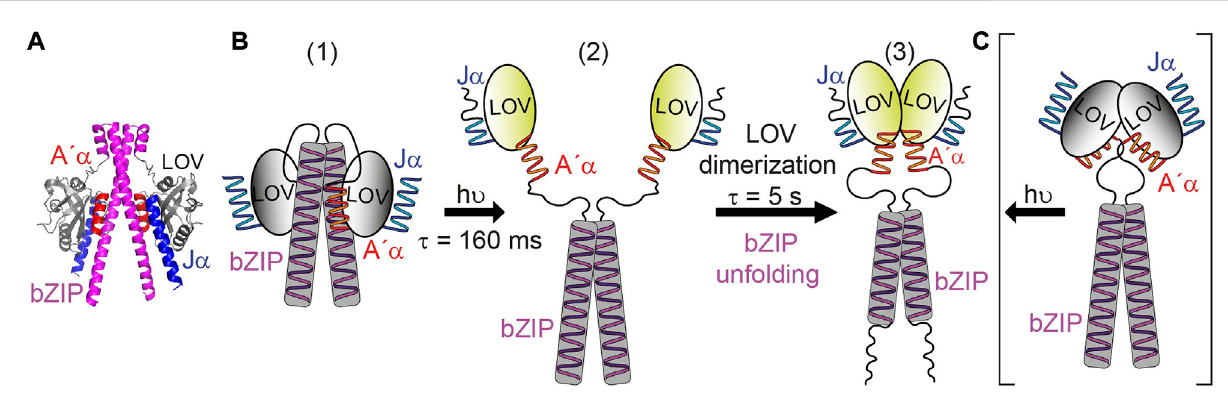
FIGURE 6 Model for the blue-light activation of bZIP-LOV from Pt Aureo1a. (A) The structure of bZIP-LOV predicted by AlphaFold2 shows an association of LOVtobZIP. (B) ThefollowingmodelisbasedonHeintzandSchlichting[18]withsomemodi fi cations.(1)Inthedarkstate,bZIP-LOVispresentasadimer with association of bZIP to bZIP and LOV to bZIP. (2) Illumination leads to an unfolding of the J α helix, subsequent reorientation of the A ’ α helix and dissociation of LOV from bZIP. This process is proposed here to proceed with the time constant of τ = 160 ms observed by transient grating experiments [21] and supported by rapid-scan FTIR spectroscopy. (3) The signaling state of bZIP-LOV is formed bydimerization of LOV and concomitant orsubsequentunfoldingofthebZIP-linkerwithatimeconstantof τ =5 s. (C) Inthecompetingmodel[22]bZIP-LOVispresentasadimerinthedarkstate in which bZIP and LOV is associated to bZIP and LOV, respectively. This model cannot explain the slow kinetics of activation of the